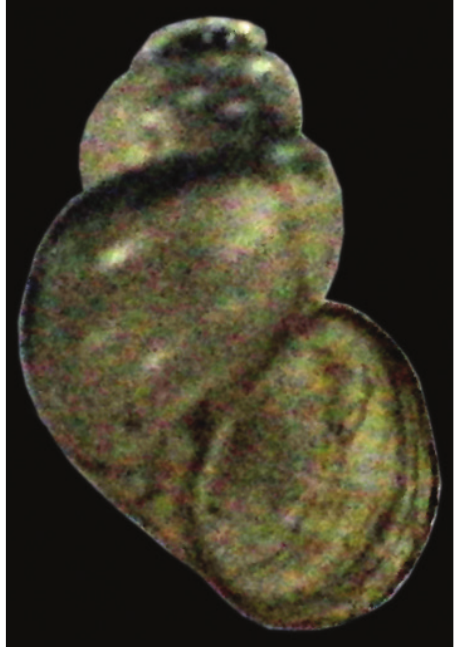
Figure 3. Erhaia spec., measurements c. 2.0×1.35 mm (photograph by E.G.). Bhutan, district Thimphu, 4.5 km E of Chuzom, W of Genekha, 2750 m alt.; 27°19'N 89°36'E; E. Gittenberger leg.